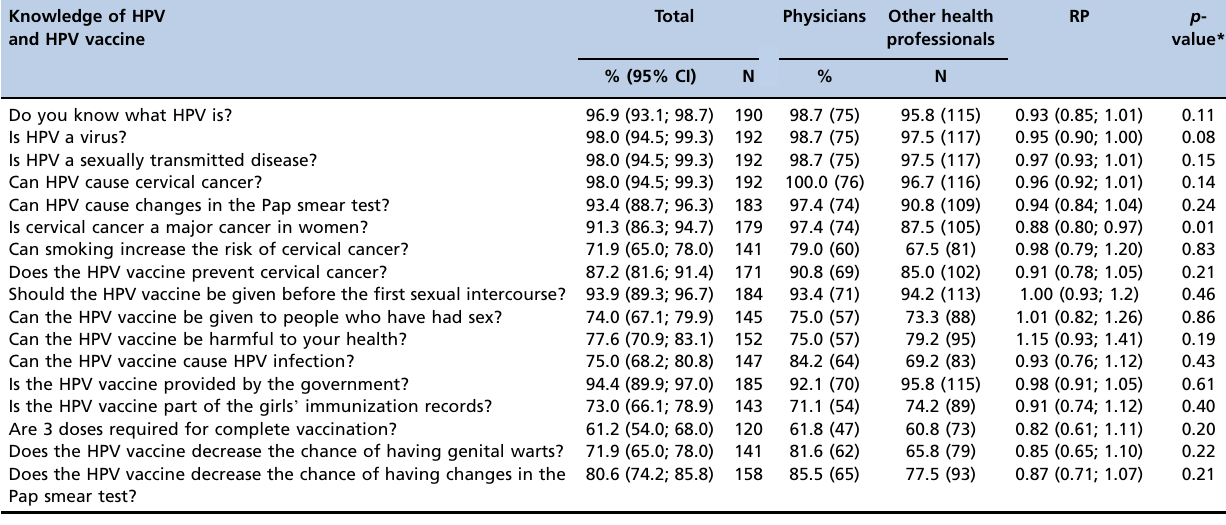
Table 2 - Knowledge of HPV among physicians and other health professionals interviewed in the Health Care System for Women and Children (SASMC) in the state of Acre, Brazil, in 2017. Knowledge of HPV and HPV vaccine